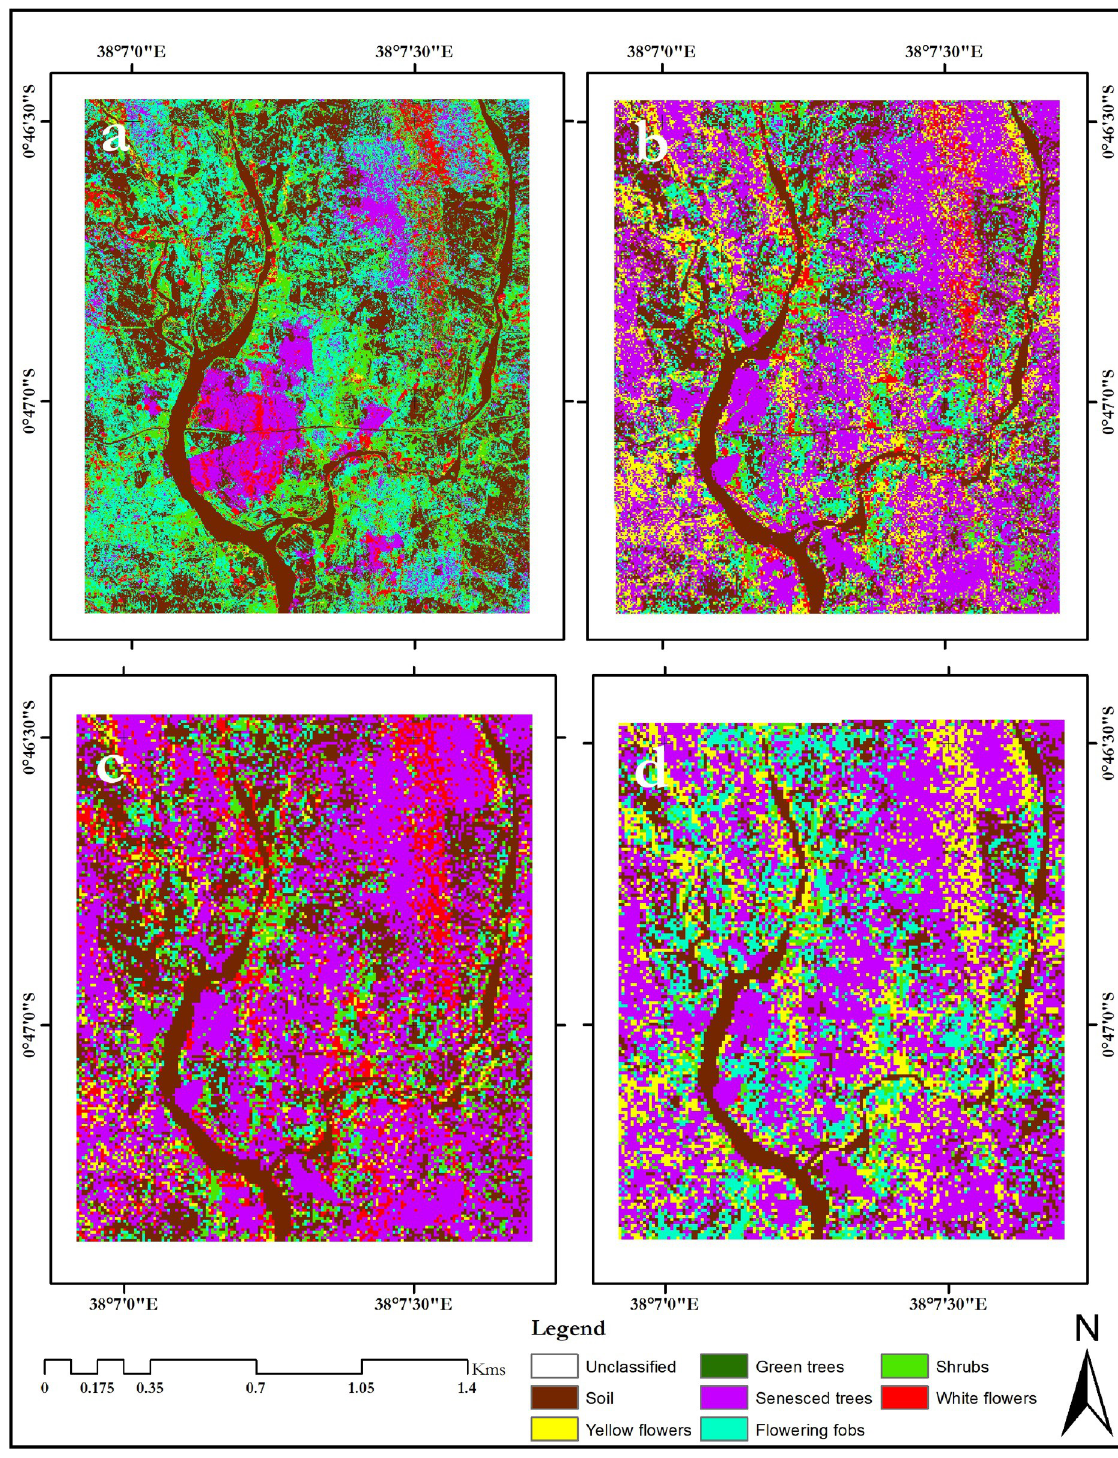
Fig 3. February 2013 classification maps of the Mwingi study site obtained using random forest classifier and resampled simulated WorldView-2 image classification (a), RapidEye (b), Spot-6 (c), Sentinel-2 (d) images. The maps were developed using QGIS software version 3.10 ( https : //qgis . org/en/site/ )[52].